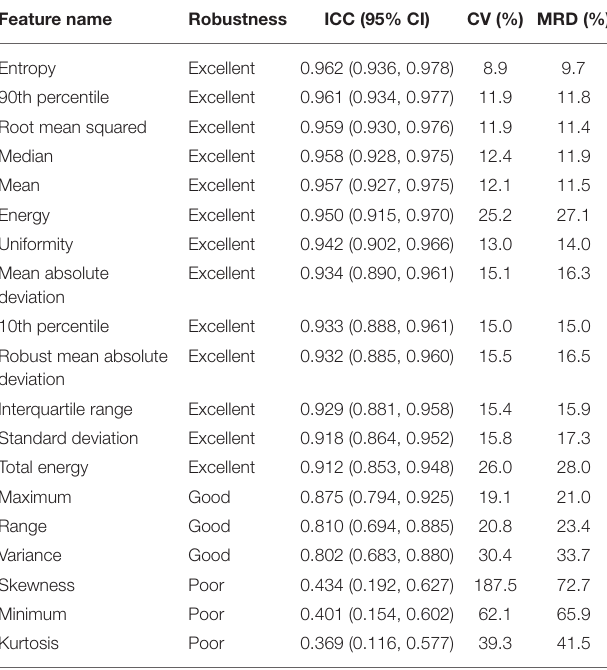
TABLE 5 | Repeatability of left ventricular myocardium first-order features in